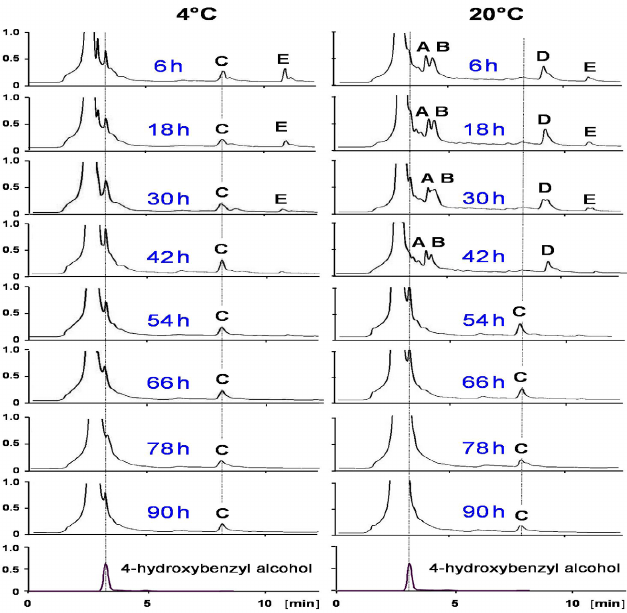
Fig. 7: HPLC analyses of M. oleifera extracts stored at 4 °C or 20 °C. Samples had been taken every 12 h. 4-Hydroxybenzyl alcohol was employed as authentic reference substance. For detection, a diode array detector was employed ( ʎ = 220 nm). Due to the HPLC condi - tions, in contrast to the LC-MS analyses mentioned above, glycosy- lated compounds, e.g. all glucosinolates, elute in the void